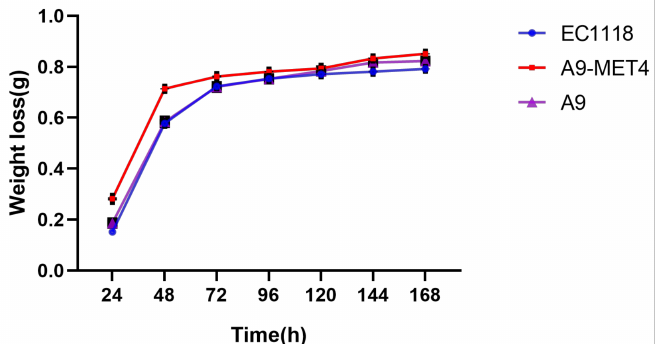
Figure 2. Weight loss curve of the transformant. Three replicates were set for each strain, each point in the figure was the mean value of three values. Values were means ±